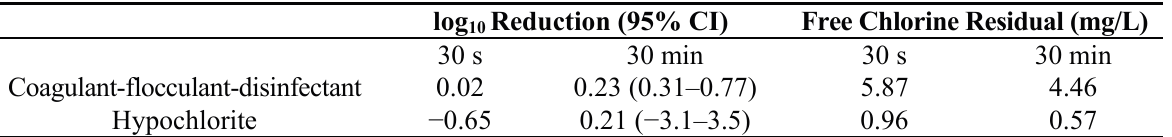
Table 1. Reduction of M. terrae in natural water by coagulant-flocculant-disinfectant and free